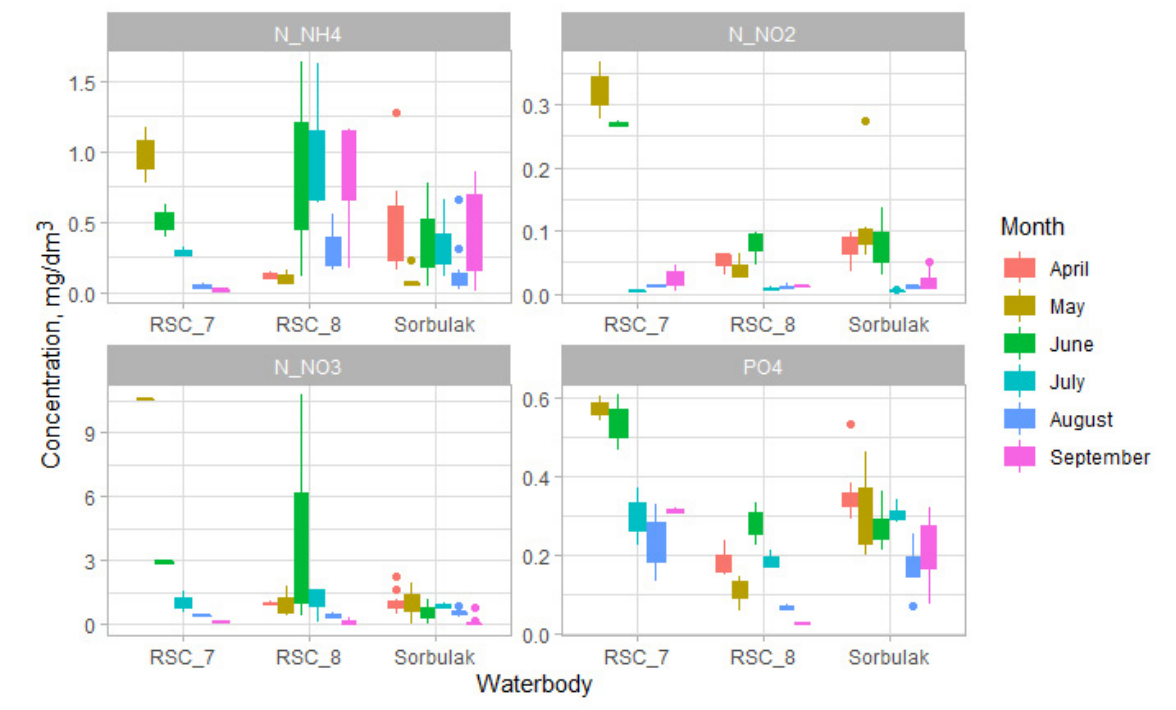
Figure 4. Dynamics of nutrients in wastewater reservoirs of the Right Bank Sorbulak Canal system during six warm months of 2021.